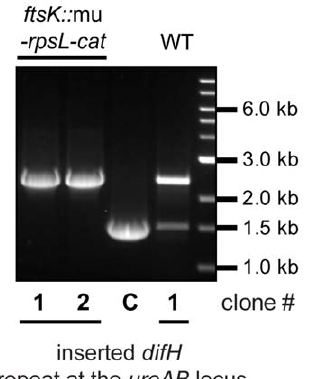
Figure 5. H. pylori FtsK is required for XerH-mediated recombination. Recombination at difH sites was scored as in Figure 2A in H. pylori 26695 Str (WT) and its derivative containing a C terminal deletion in ftsK , in each case with the difH repeat cassette at the ureAB locus.